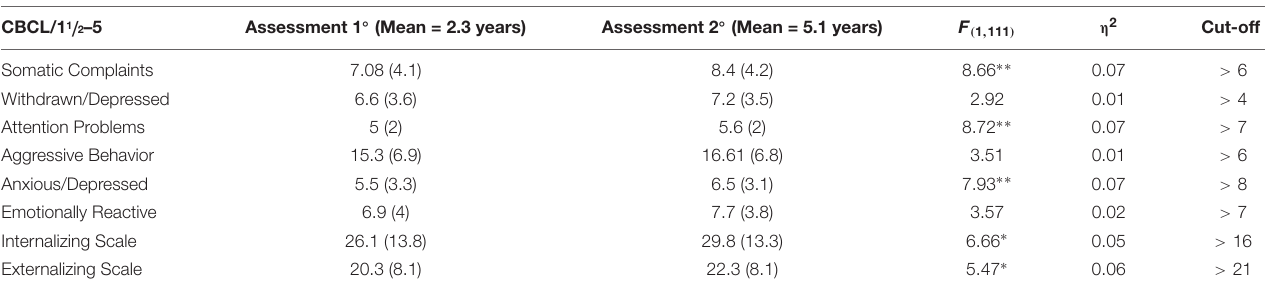
FIGURE 2 | Assessments of the different types (chronic, acute, acute/chronic) and degree (mild, moderate, severe) of malnutrition. The vertical axis reports mean points of degree of malnutrition (from 0 = none to 3 = severe). TABLE 3 | Means (SD) of the CBCL/1 1 / 2 –5 at the Assessment 1 ◦ and at Assessment 2 ◦